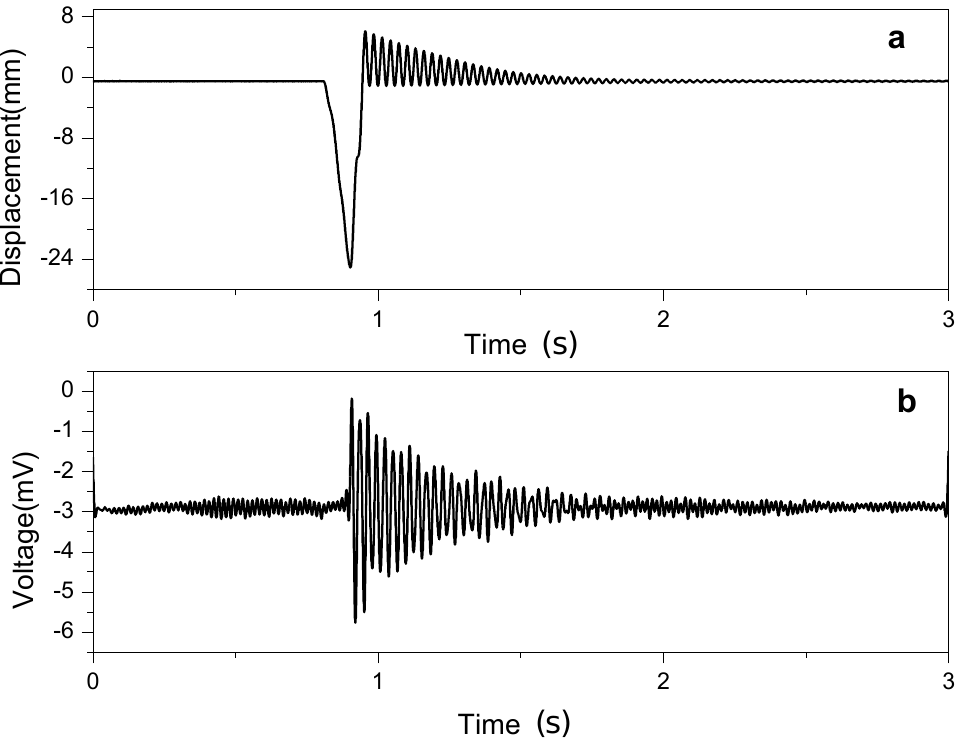
Figure 7. Bending mode strain sensor: ( a ) bending displacement and ( b ) sensor